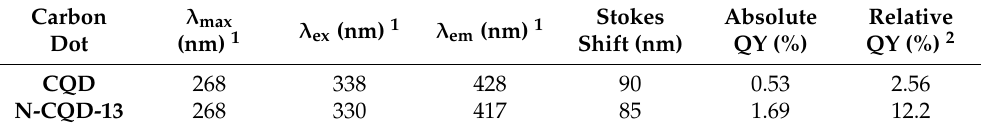
Table 7. Optical properties of CQD and N-CQD-13 .